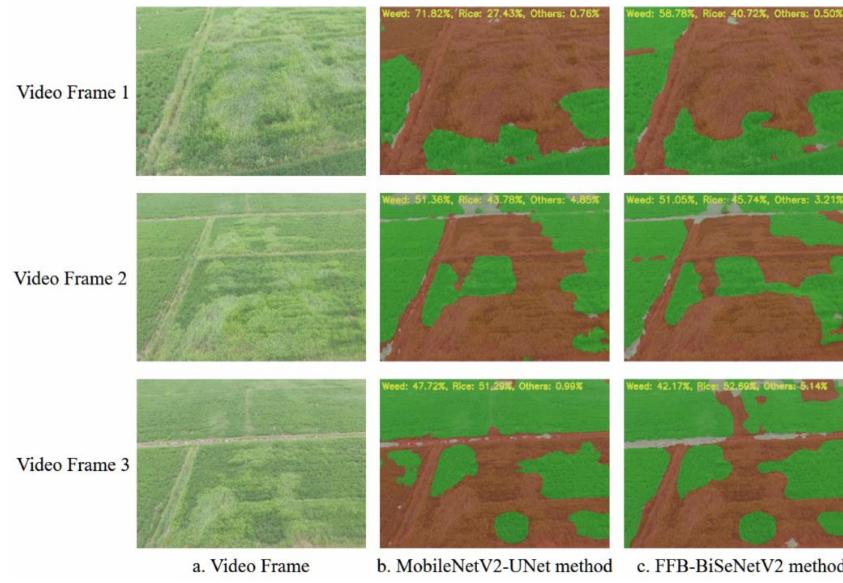
Figure 14. Real-time segmentation result of the improved semantic segmentation